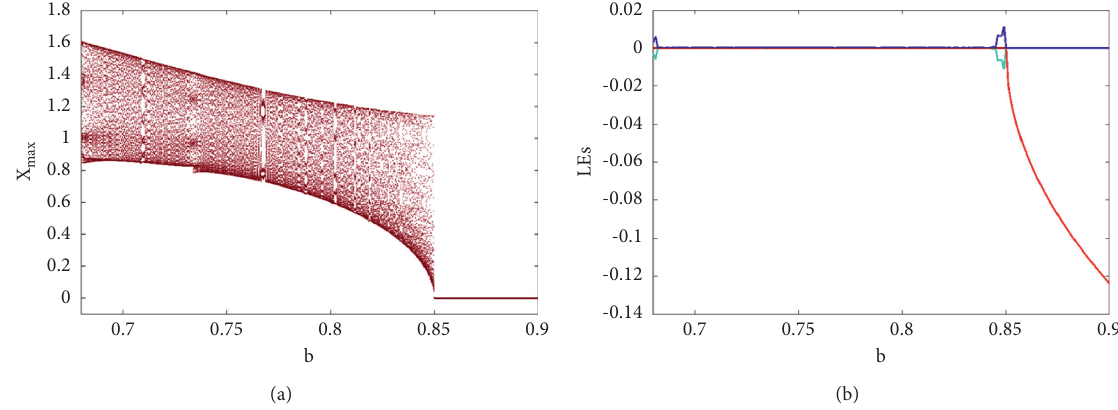
Figure 6: (a) Bifurcation diagram and (b) LEs of oscillator (1) by changing parameter b with constant initial conditions ( x ,y ,z ) � (− 0 . 57 , − 0 . 99 , − 0 . 71 ) 0 0 0